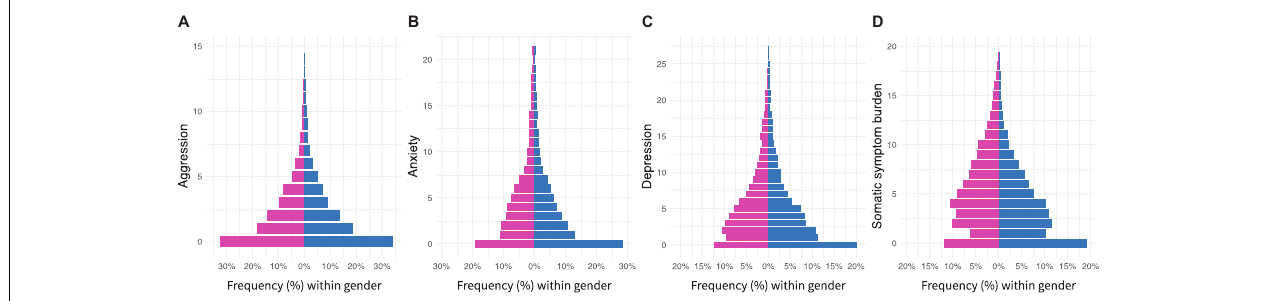
FIGURE 1 | Differences between men ( n = 3553) and women ( n = 7426) at mental health measures: (A) aggression, (B) anxiety, (C) depression, and (D) somatic symptom burden. Gender is color-coded (blue for men). Bars represent relative percentages within gender. TABLE 1 | Summary statistics of all variables used in the study differentiated by gender.